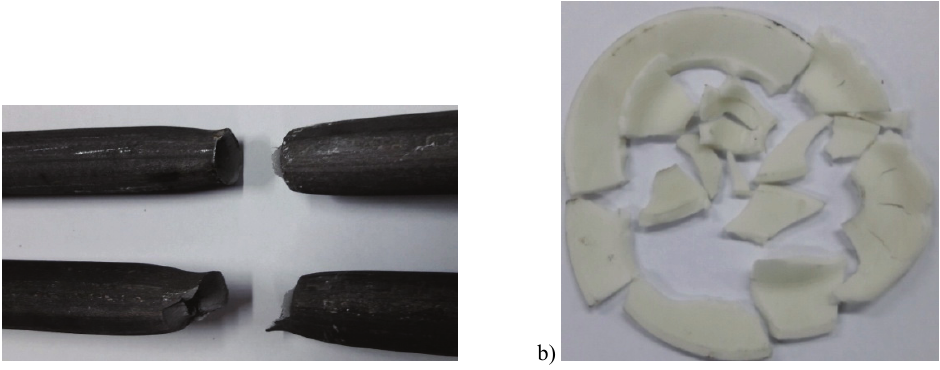
Fig. 12. Destruction of the studied materials: a) break on the bolt rod, b) destruction of the plastic bearing plate (photo by K.